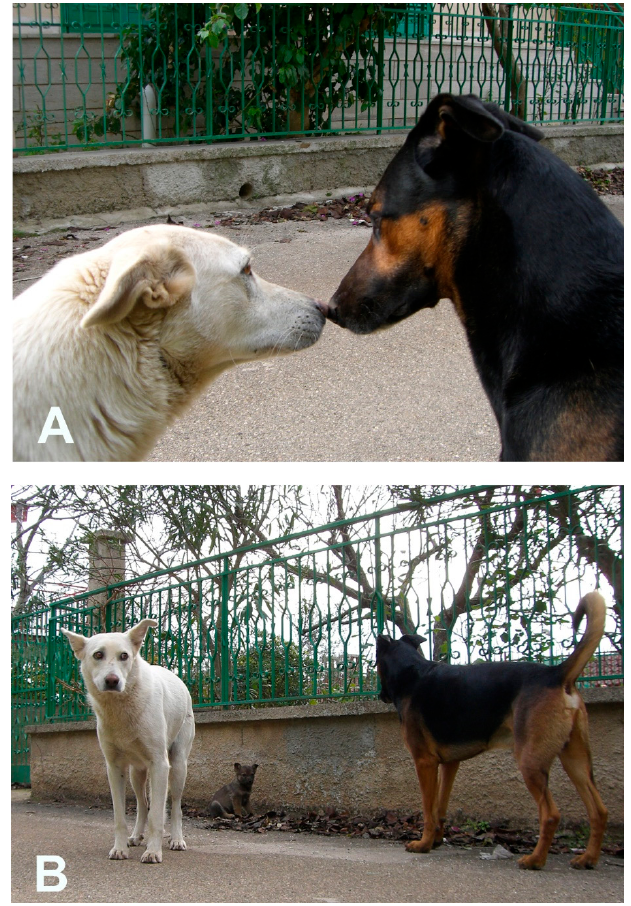
Figure 3. Free ‐ ranging dogs. ( A ) The black male displays courtship behavior. His expression shows a closing distance request. ( A , B ) The female is showing her intention to avoid a conflict, but also her firm intention to enhance distance to protect her puppy.